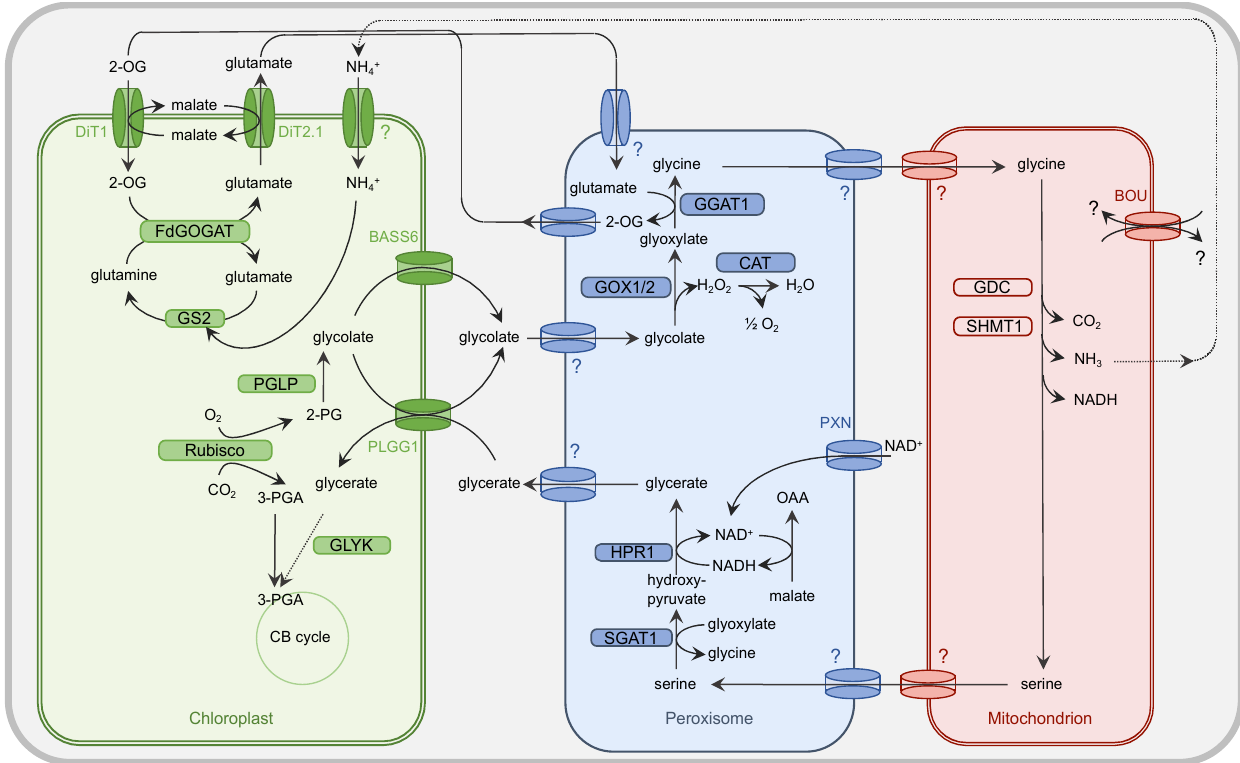
Figure 1. Simplified presentation of the plant PR metabolism. Oxygenation activity of Rubisco within the chloroplast results in the generation of one molecule of 3-PGA and 2-PG each. While 3-PGA is metabolized in the CB cycle, 2-PG is degraded by the PR metabolism. Within the chloroplast, 2-PG is dephosphorylated by 2-PG phosphatase (PGLP). Formed glycolate is exported from the chloroplast by PLGG1 and BASS6 and enters the peroxisome by a yet unidentified (?) translocator. Glycolate oxidase (GOX1/2) generates glyoxylate and H 2 O 2 . The latter one is converted by catalase (CAT) activity into O 2 and H 2 O. The PR intermediate glyoxylate is aminated by glutamate:glyoxylate aminotransferase (GGAT1) to yield glycine. Glutamate serves as a donor for the amino group. The peroxisomal importer for this amino acid but also glycine is to date unknown. Glycine needs to be imported by an unknown translocator into the mitochondrion. Here, the concerted action of the multienzyme system glycine decarboxylase (GDC) and serine hydroxymethyltransferase (SHMT) results in release of CO 2 and NH 3 from one molecule of glycine but also conversion of another molecule of glycine into serine. The substrate(s) of the transporter À BOU DE SOUFFLE (BOU) are unclear. BOU is likely involved in mitochondrial glutamate transport and functionally linked with glycine-to-serine conversion. Export of serine from the mitochondrion is facilitated by an unknown transporter protein. This applies also to the import into the peroxisome. Serine is deaminated by serine:glyoxylate aminotransferase (SGAT1) to form hydroxypyruvate. For the subsequent reduction of this intermediate to glycerate, hydroxypyruvate reductase 1 (HPR1) depends on NADH, which is provided by the oxidation of OAA into malate. NAD + is basically imported into peroxisome by the peroxisomal NAD carrier PXN. Glycerate leaves the